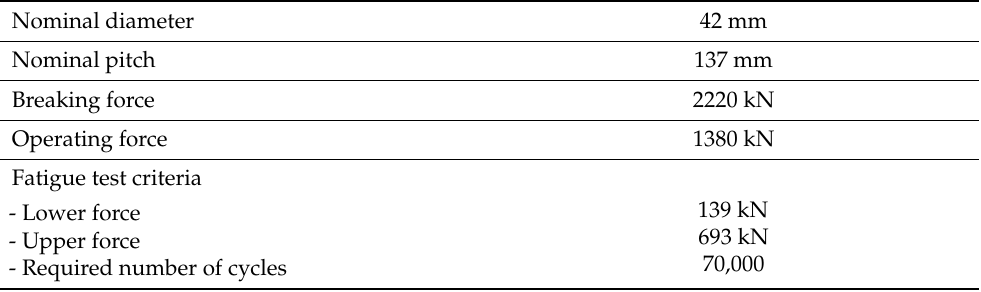
Table 1. Parameters of the plough chain.